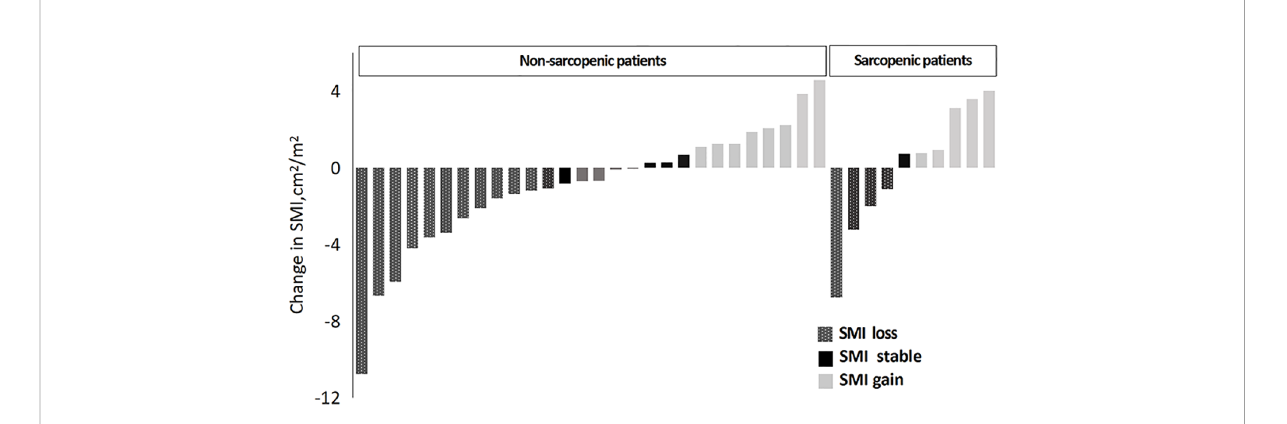
FIGURE 3 Change in skeletal muscle index in patients according to sarcopenia.